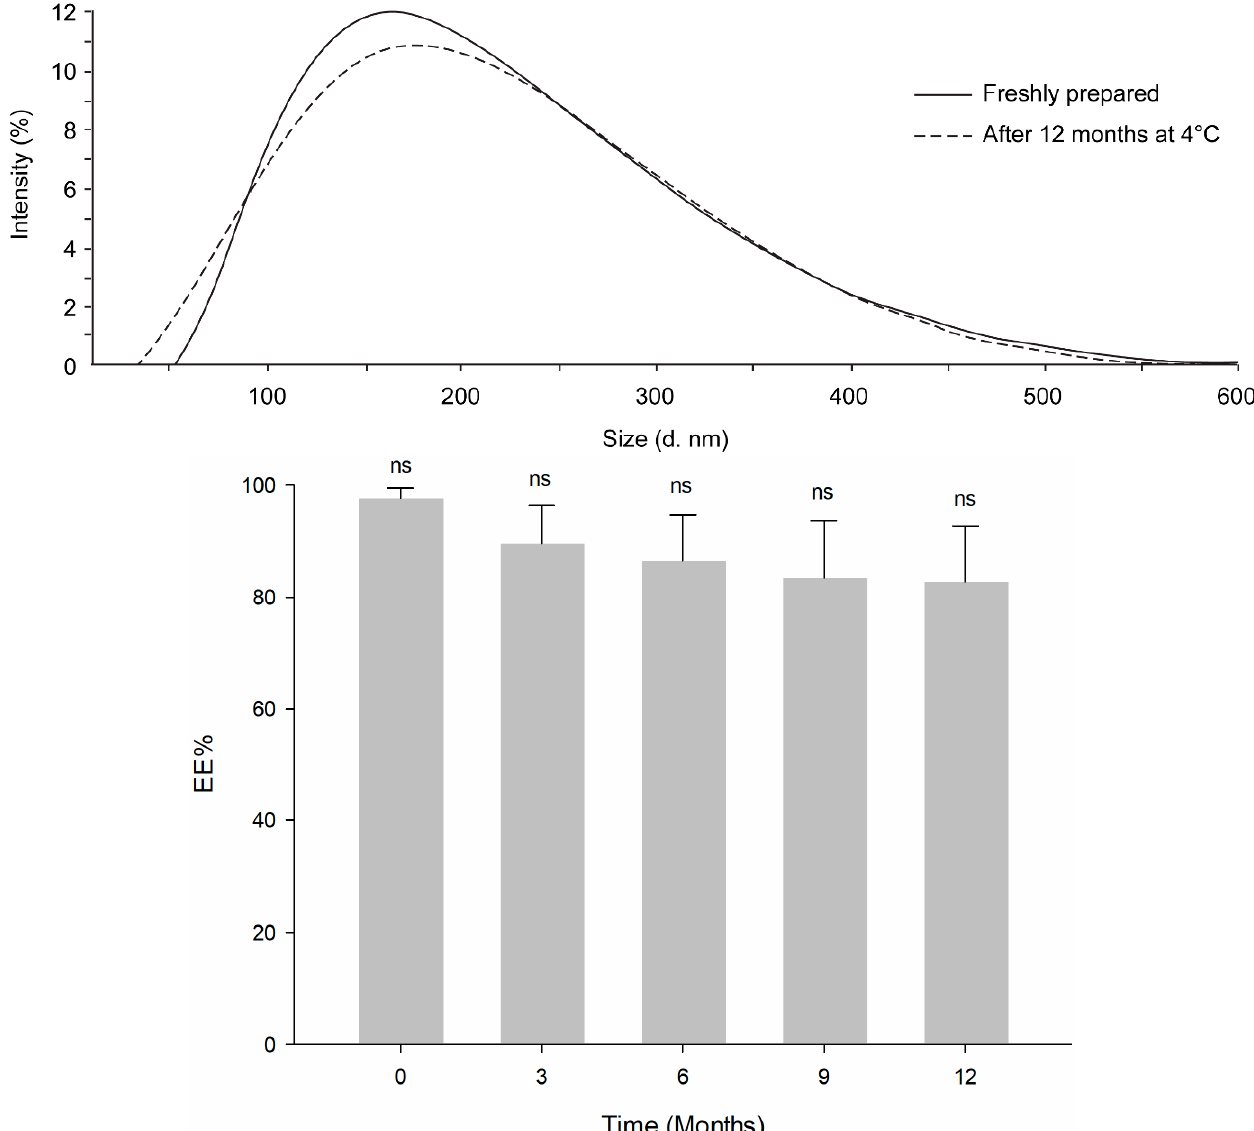
Figure 3. NLC formulations are stable over time. Stability of NLCs-DXM formulation after 12 months stored at 4 °C. Upper panel : size distribution- Original sample: Mean diameter: 145.0 ± 0.8 nm; PDI: 0.20 ± 0.01; older formulation: size: 150.8 ± 2.5 nm; PDI: 0.24 ± 0.02; lower panel : evolution of the EE measured every 3 months, ( n = 3); no significant difference (ns) (Two-way ANOVA, Dunnett’s multiple comparisons test).